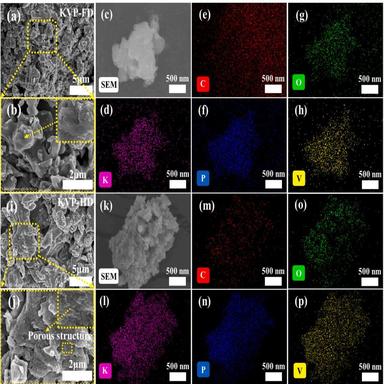
(a-b, i-j) SEM images and (c-h, k-p) SEM-EDS mapping of selected area in the KVP-FD and KVP-HD materials.